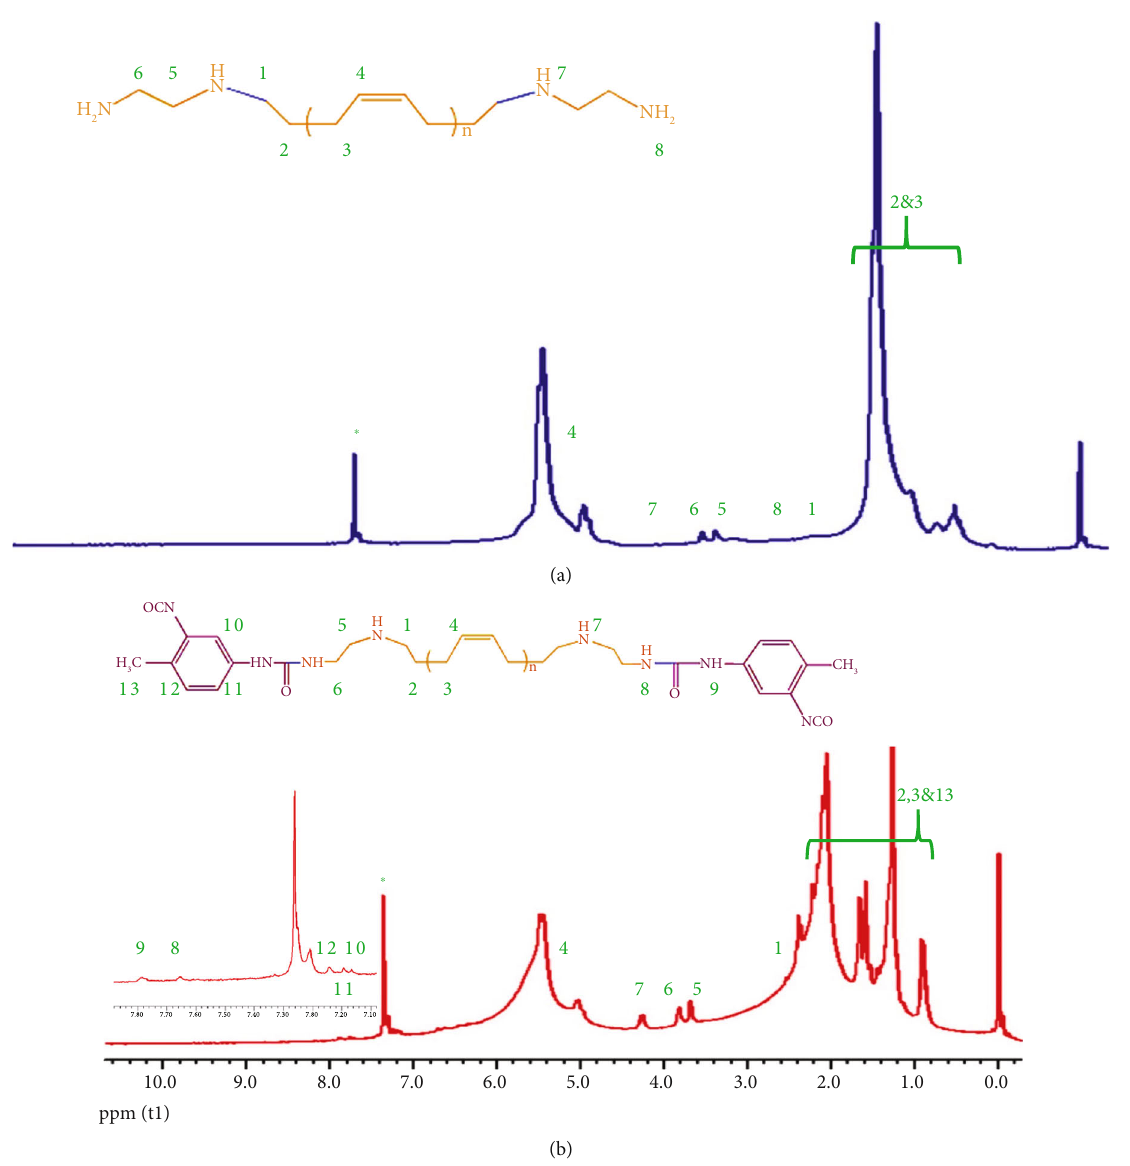
Figure 2: 1 H-NMR spectra for stepwise synthesis of PUr. (a) Am and (b) PUr (*CDCl